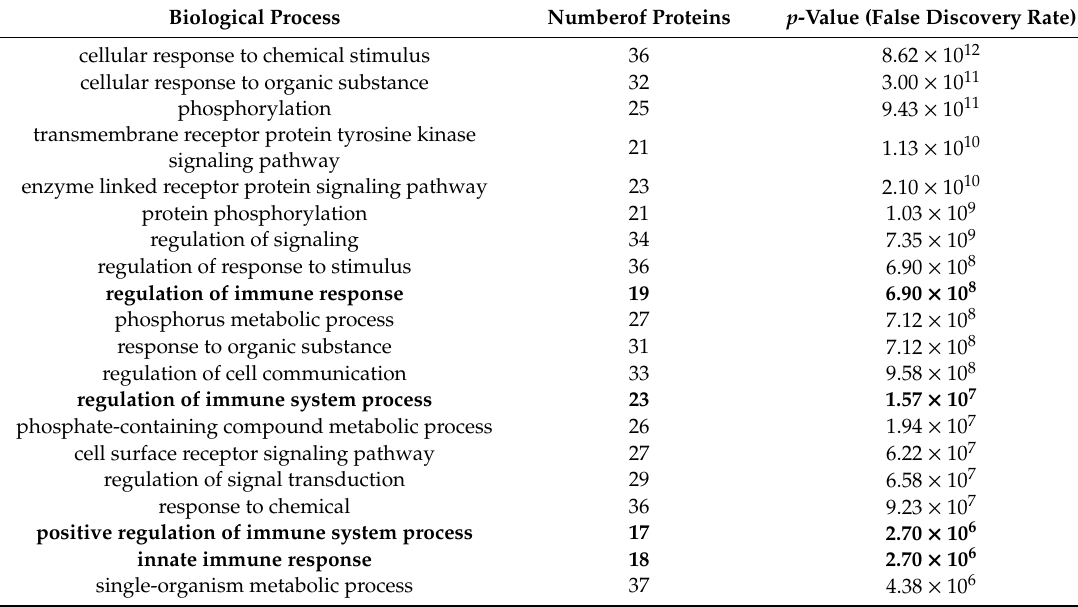
Table 4. Top 20 gene ontology (GO) biological processes enriched from unique peptides in the postbiotic-treated jejunum (compared to C. perfringens challenge and postbiotic plus C. perfringens challenge